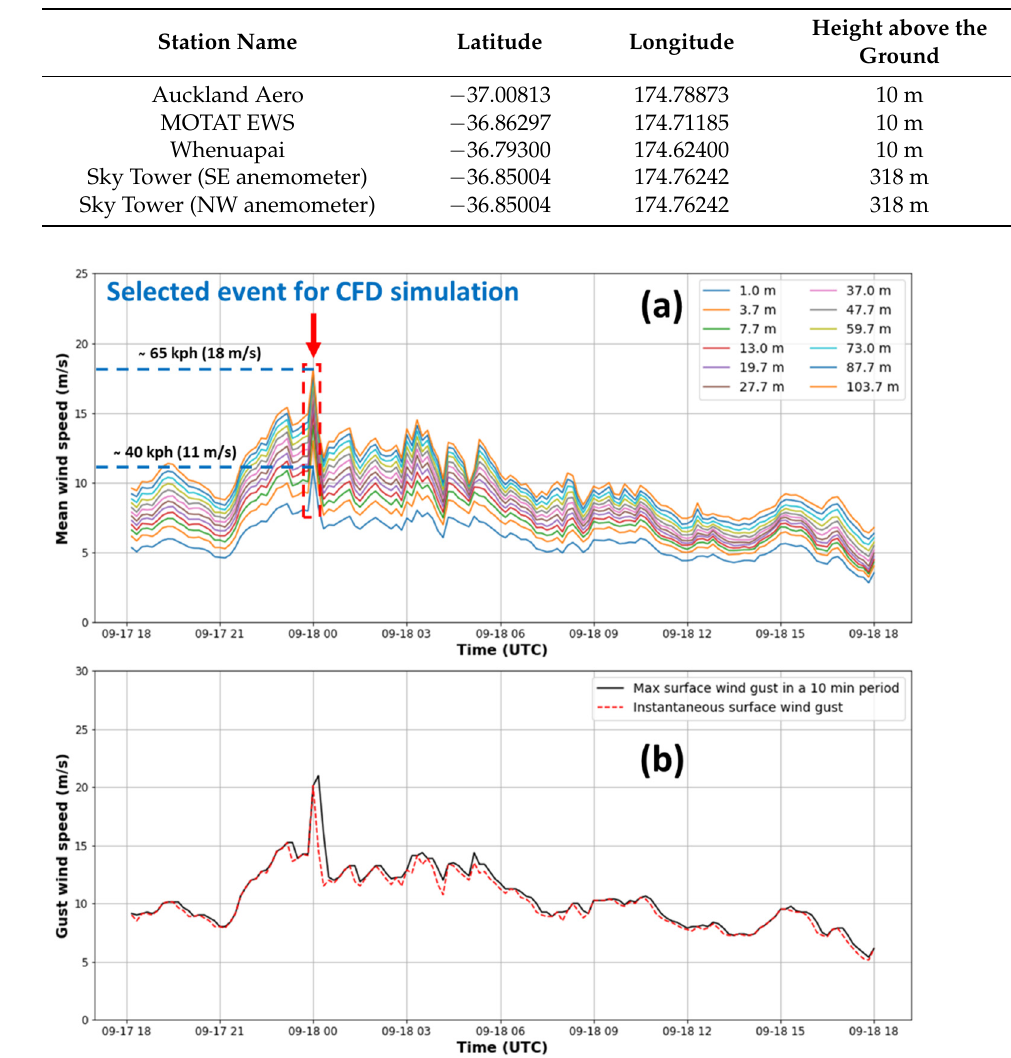
Figure 3. Mean ( a ) and gust ( b ) wind speed time series outputs of the 333 m model upstream of the Auckland Harbour Bridge, during the extreme westerly event on 18 September 2020.